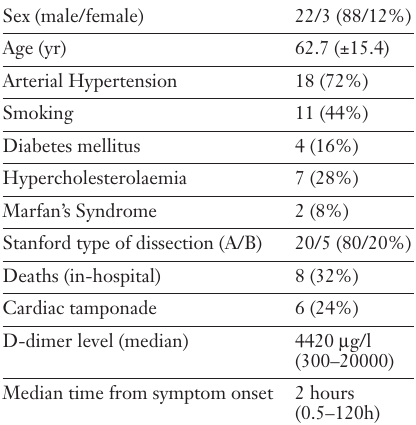
Baseline characteristics of 25 patients with AD.